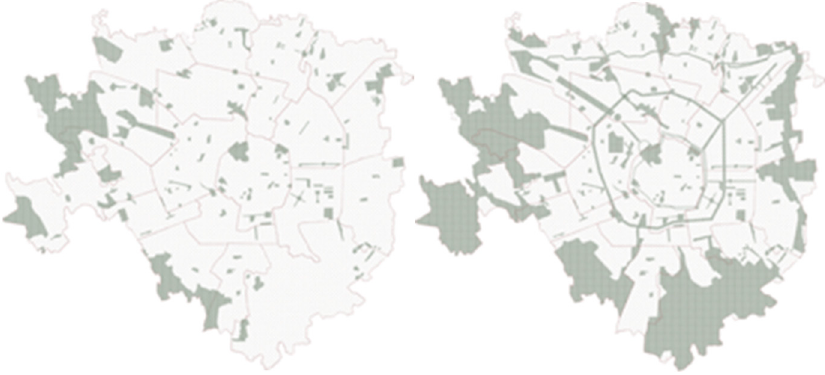
Figure 10. The green areas in Milan in 2020 ( left image) vs. 2030 ( right image) [12].